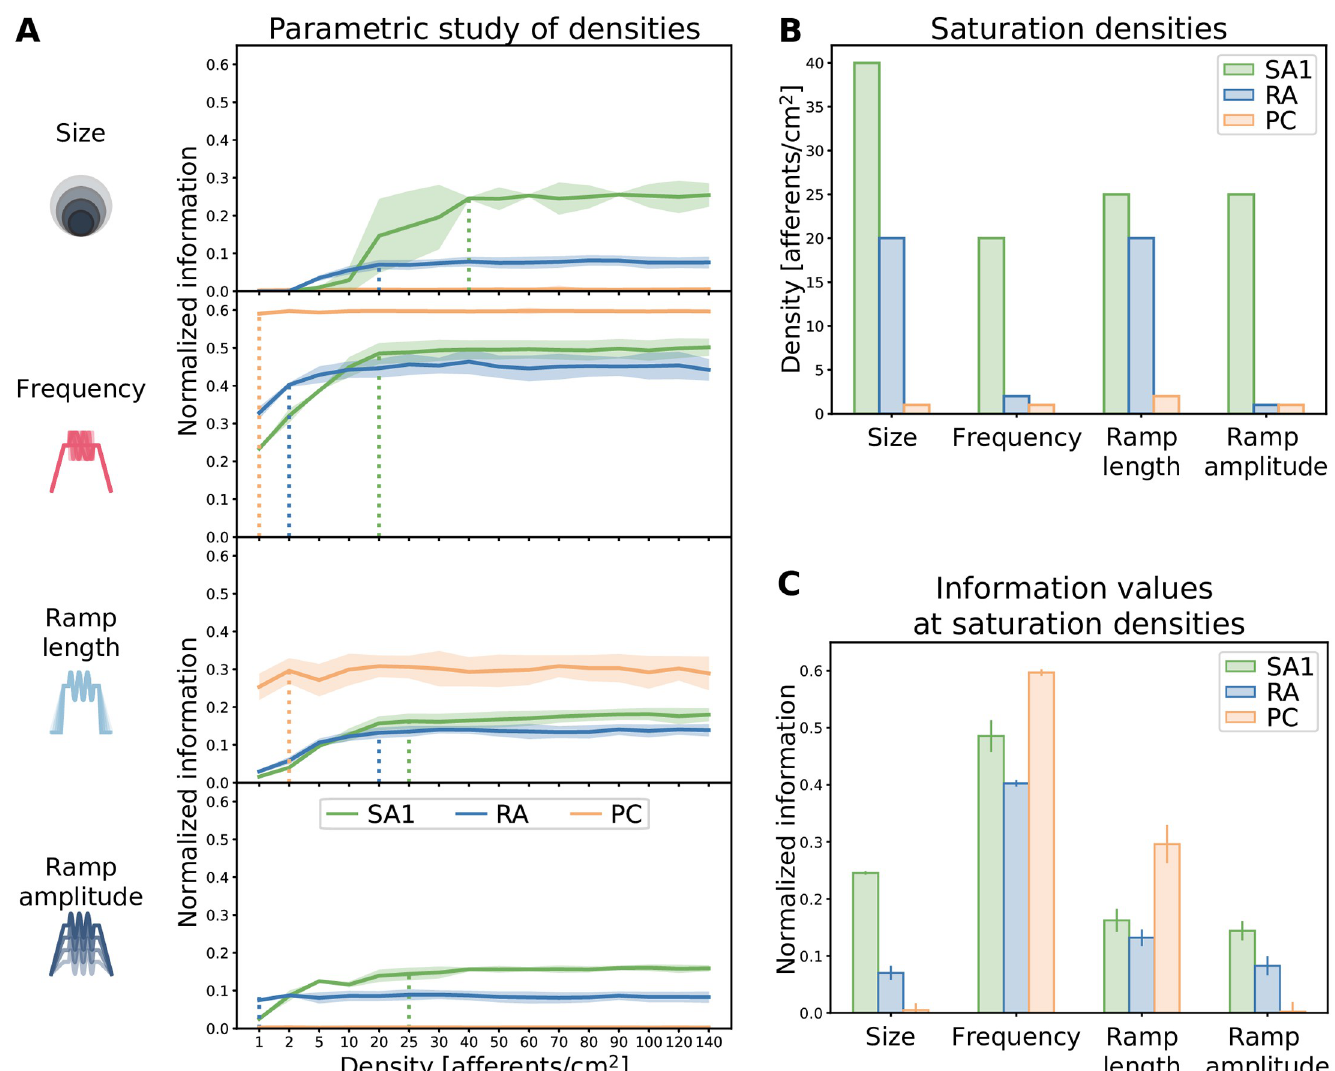
Fig 3. Effect of afferent density on stimulus feature coding. (A) Information content (normalized by the stimulus entropy) for different stimulus features provided by single-class afferent populations of varying density. Solid lines represent the average over 40 trials, shaded regions represent standard deviation across NMF instantiations. Dotted vertical lines indicate information saturation points. (B) Saturation densities for each feature and afferent class. (C) Maximum information content provided by each afferent class at the saturation density for each feature. Error bars represent standard deviation across NMF instantiations.